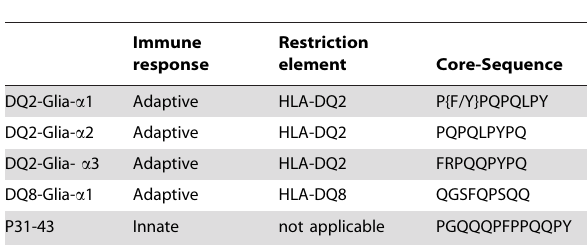
Table 1. Amino acid sequences of a -gliadin derived peptides.